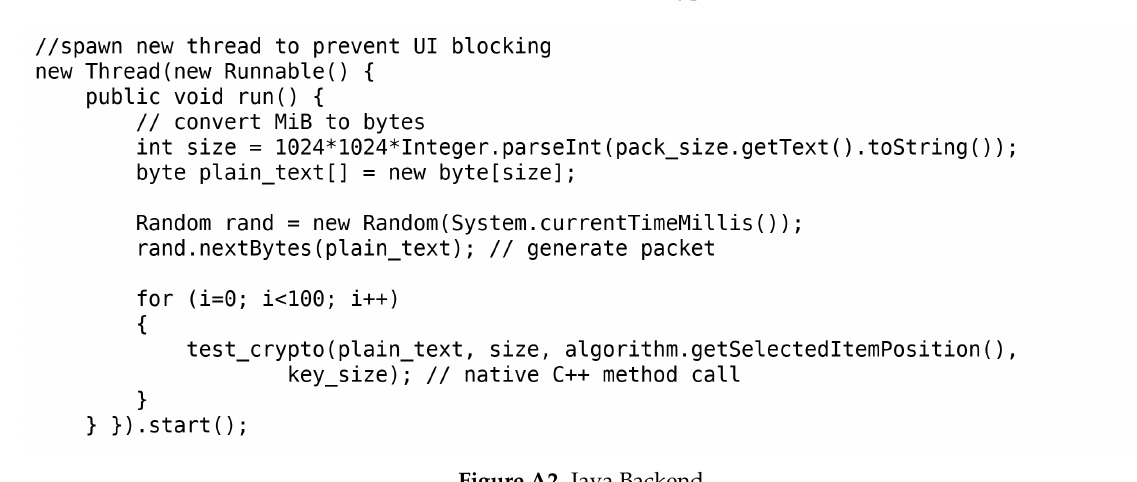
Figure A1. AES-Galois/counter mode (GCM) encryption with time measurement.